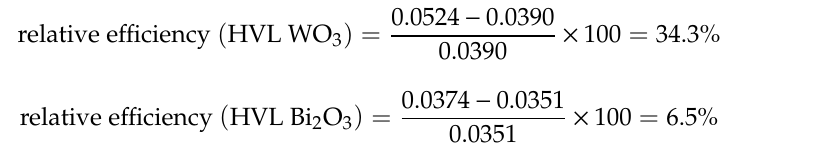
Figure 6. Half-value layer (HVL) of all the samples.